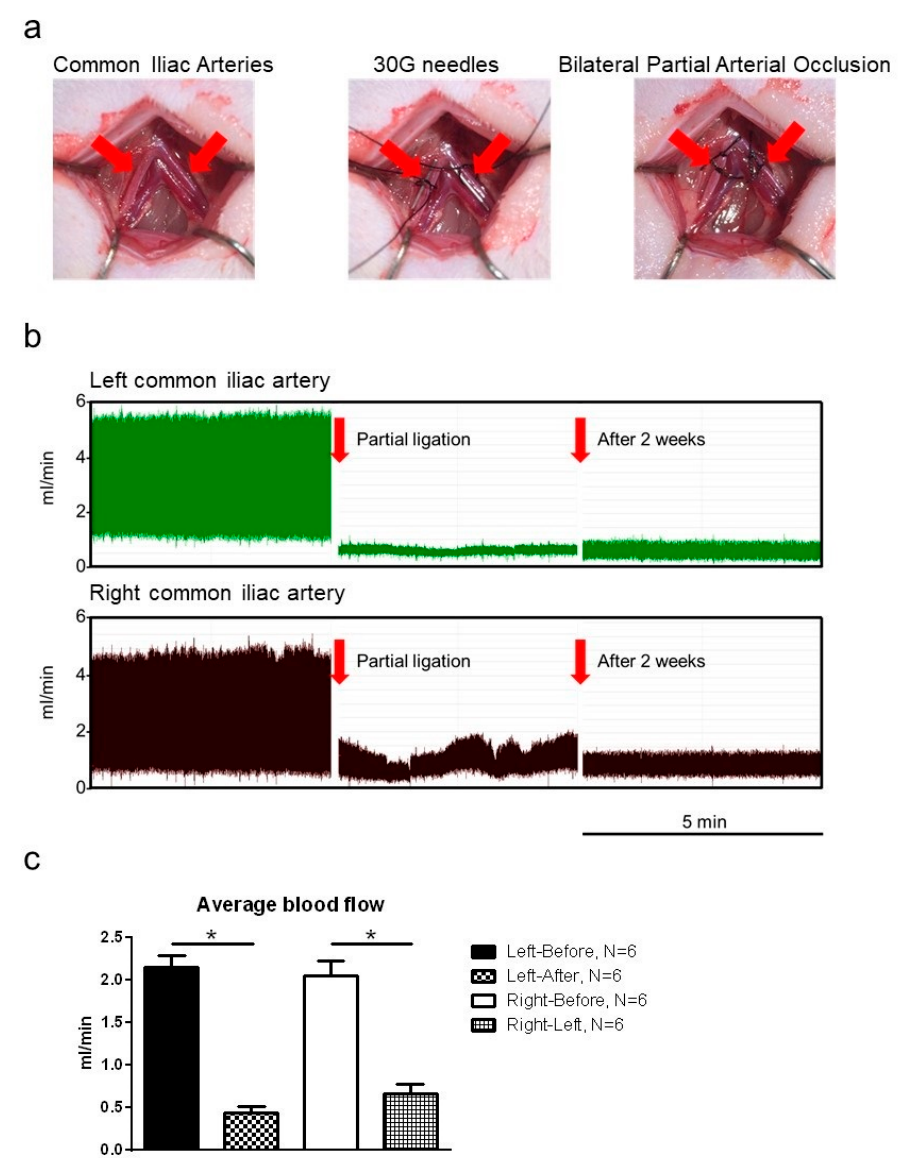
Figure 1. BPAO and the blood flow measurement. In the top panel, ( a ) showed the bladder ischemia model, BPAO. In the middle panel, ( b ) showed changes in blood flow of respective left and right common iliac artery with Doppler flowmetry before, after, and 2 weeks later following BPAO. In the bottom panel, ( c ) showed the blood flow of respective left and right common iliac arteries 2 weeks after BPAO significantly reduced compared to that before BPAO (* p < 0.05 with paired t - test).